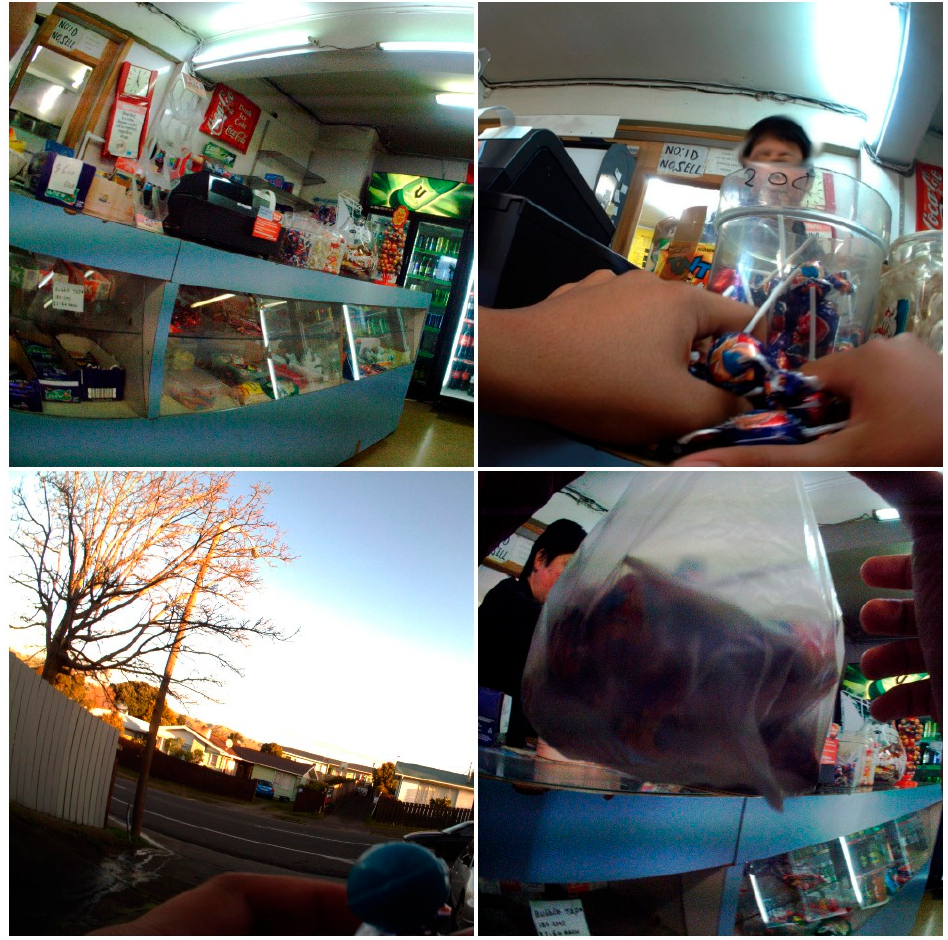
Figure 3: Food and drink purchase and consumption image sequence. Top left: countertop with confectionary displayed beside and beneath the counter. Top right: lollipops selected by participant for purchase. Bottom right: lollipops in a bag following purchase. Bottom left: consumption of lollipop